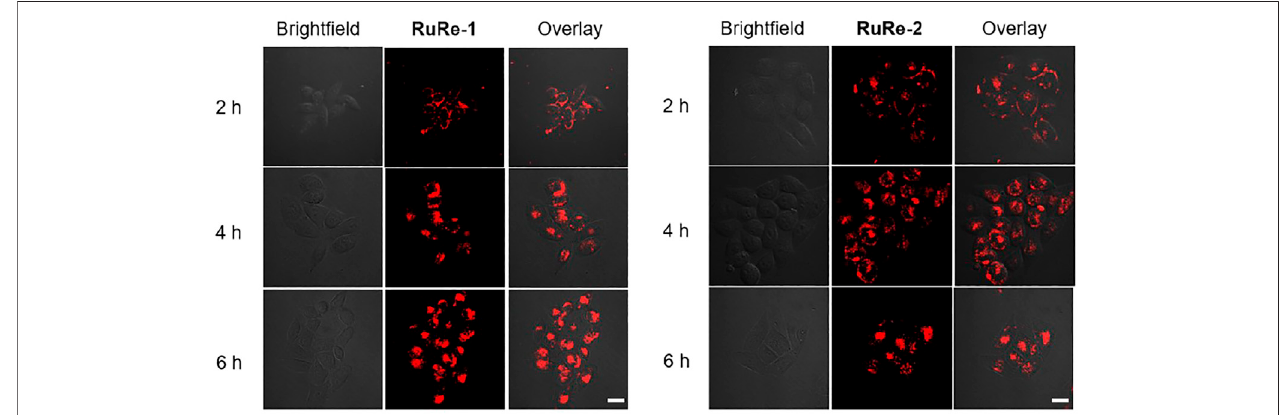
FIGURE1| Intracellular uptakeof RuRe-1 (10 μ M) and RuRe-2 (10 μ M)measured byconfocal microscopy ( λ ex =488 nm, λ em =590±20 nm).Scale bar:20 μ m.